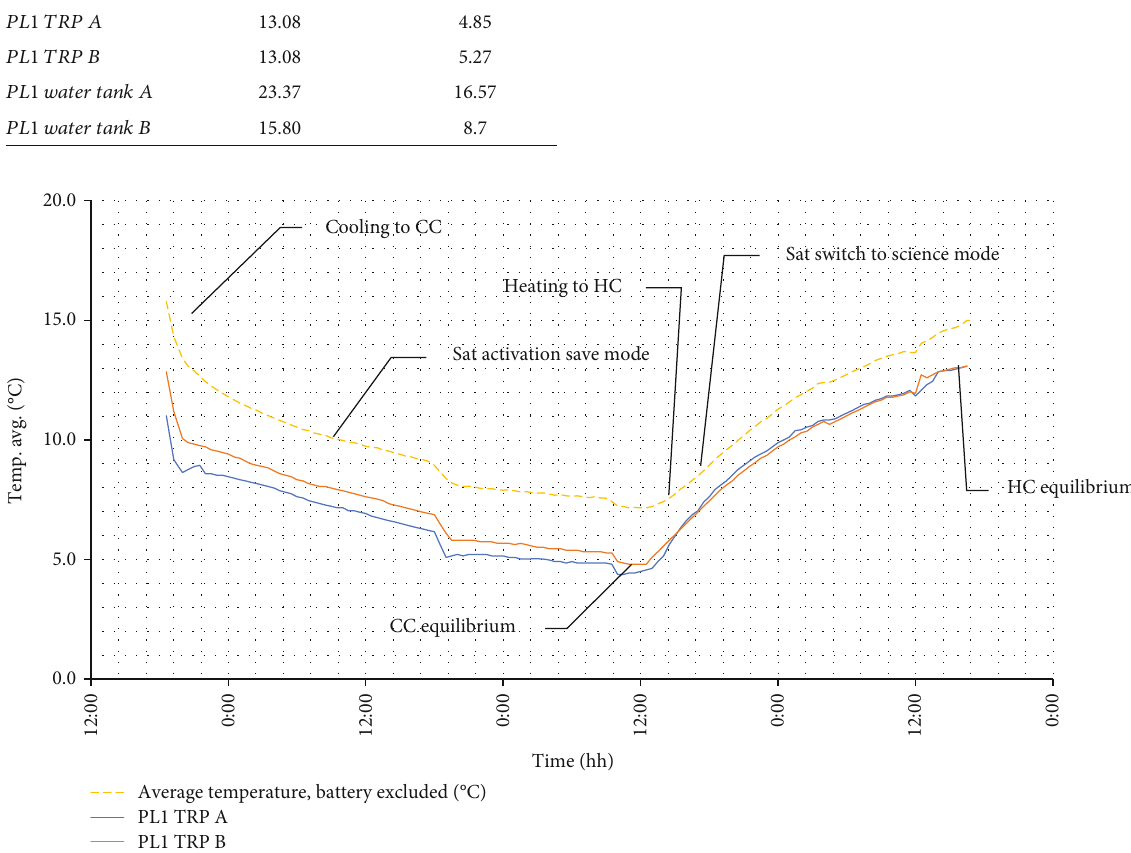
Figure 11: Eu:CROPIS Thermal Balance Test — setting and result